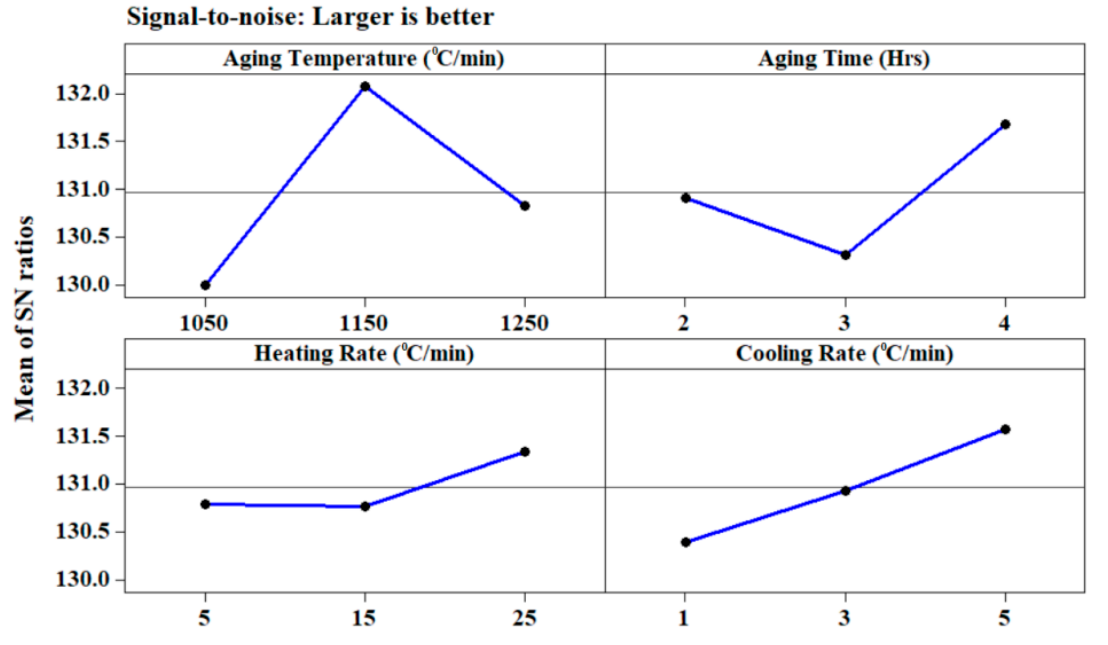
Figure 10. Main effects plot for electrical conductivity ( Ω − 1 m − 1 ).